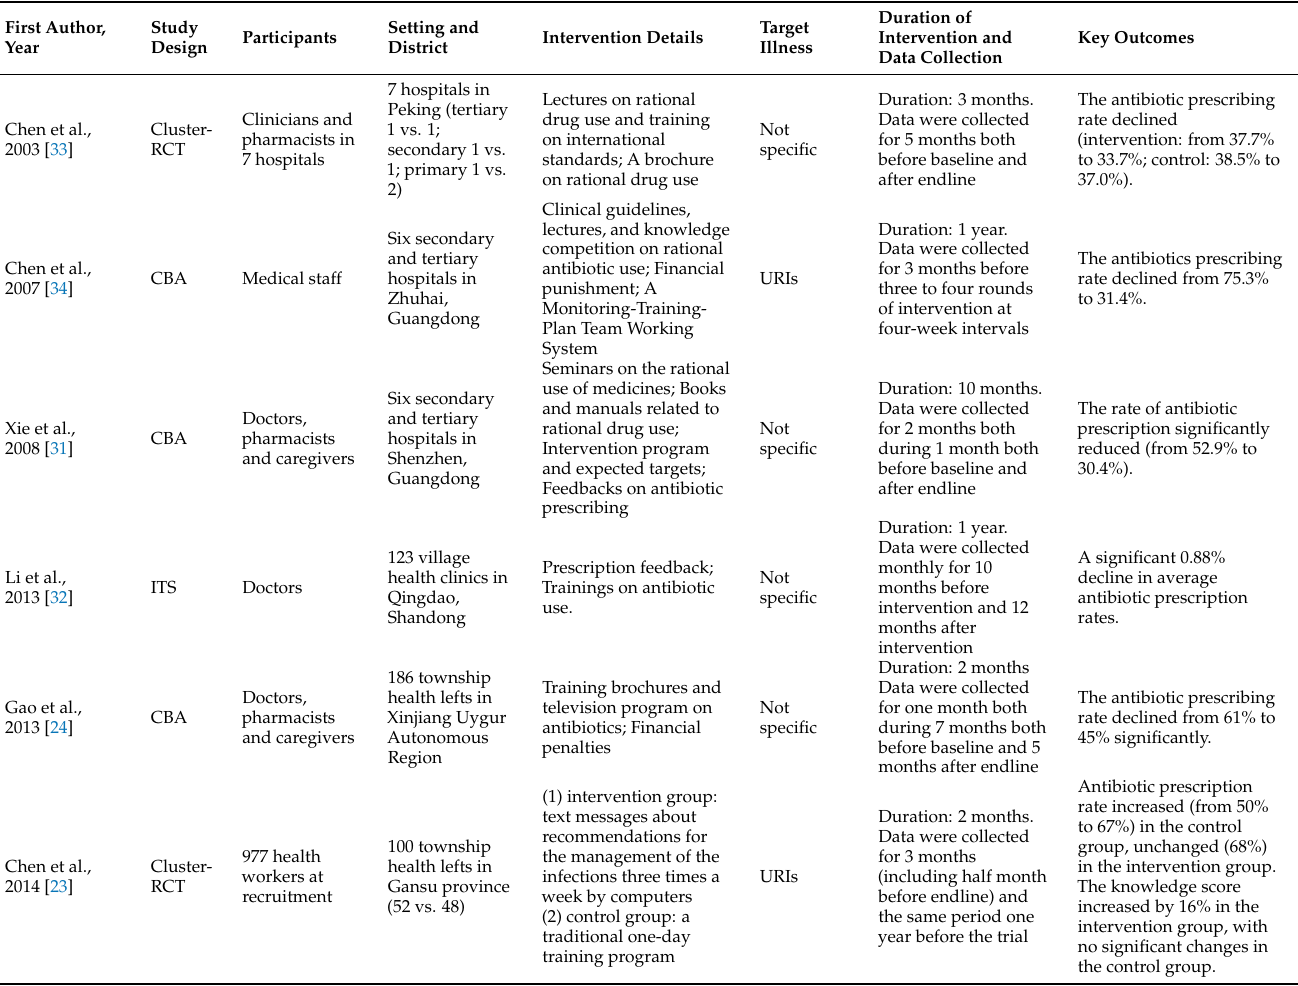
Table 1. Characteristics of included studies analyzing the effect of education-only intervention or plus other